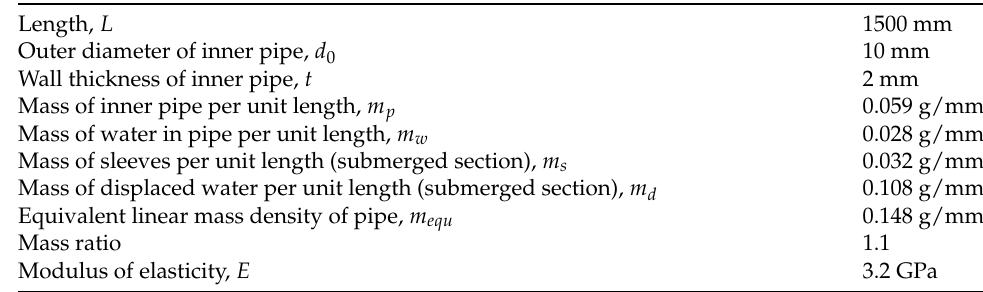
Table 3. Basic physical and hydrodynamic properties of the flexible pipe. Length, L 1500 mm Outer diameter of inner pipe, d 0 10 mm Wall thickness of inner pipe, t 2 mm Mass of inner pipe per unit length, m p 0.059 g/mm Mass of water in pipe per unit length, m w 0.028 g/mm Mass of sleeves per unit length (submerged section), m s 0.032 g/mm Mass of displaced water per unit length (submerged section), m d 0.108 g/mm Equivalent linear mass density of pipe, m equ 0.148 g/mm Mass ratio 1.1 Modulus of elasticity, E 3.2